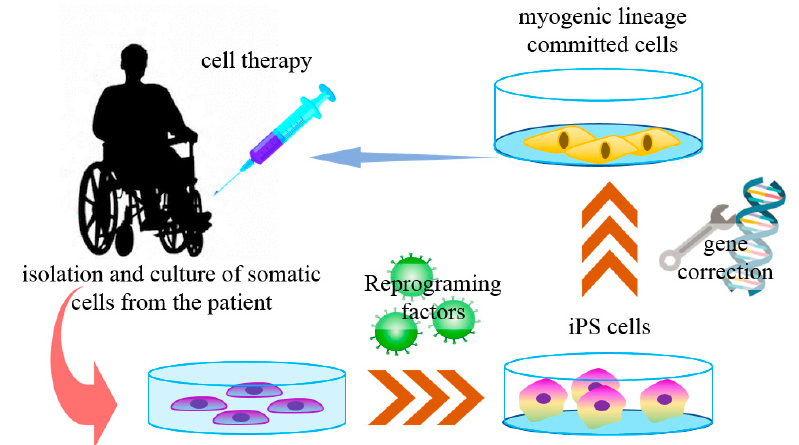
Figure 2. iPS cells in Duchene muscular dystrophy cell therapy. The somatic cells derived from specific patients with Duchenne muscular dystrophy (DMD) can be reprogrammed into iPS cells with reprogramming factors. These cells are then genetically corrected to express the protein dystrophin for the autologous muscular injection of muscle-committed cells.